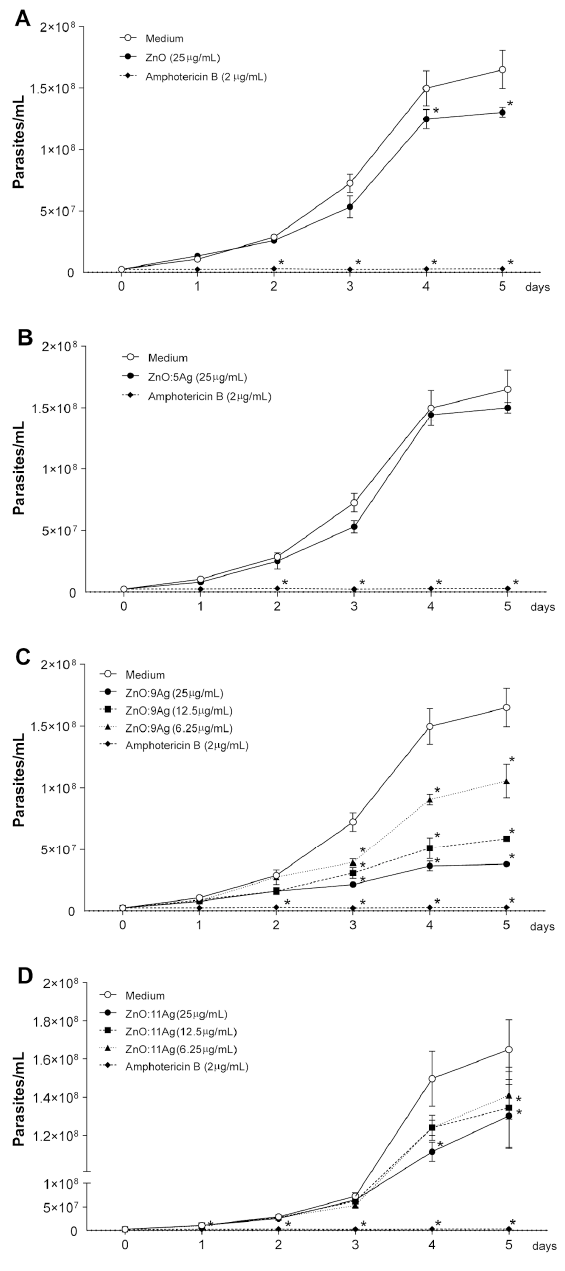
Figure 2. Evaluation of parasitic proliferation when treated with different nanoformulations. The inhibition of proliferation of L.b treated with the different nanomaterials was evaluated by counting the parasites in a Neubauer chamber after fixation with ice-cold 0.2% PFA every 24 h for 5 days. The results are expressed as the mean ± SEM (standard error of the mean), and two-way ANOVA of multiple comparisons was applied, with values of p < 0.05 (*) being considered significant when compared to cell culture without treatment (medium). Cells untreated (medium) and treated with anti-CD3 and anti-CD28 stimuli were used as negative and positive controls, respectively. ( A ) ZnO nanocrystals at a dose of 25 µ g/mL reduced the proliferation of L.b. promastigotes from day 4, while in the treatment with ZnO:5Ag ( B ) NCPs, there was no significant difference on any of the days analyzed. ( C ) ZnO:9Ag NCPs reduced L.b parasite proliferation from the third day of treatment from the lowest dose tested. ( D ) Treatment with ZnO:11Ag NCPs caused a decrease in the proliferation of promastigote forms from day 4 at a dose of 25 µ g/mL and on day 5 at a dose of 12.5 µ